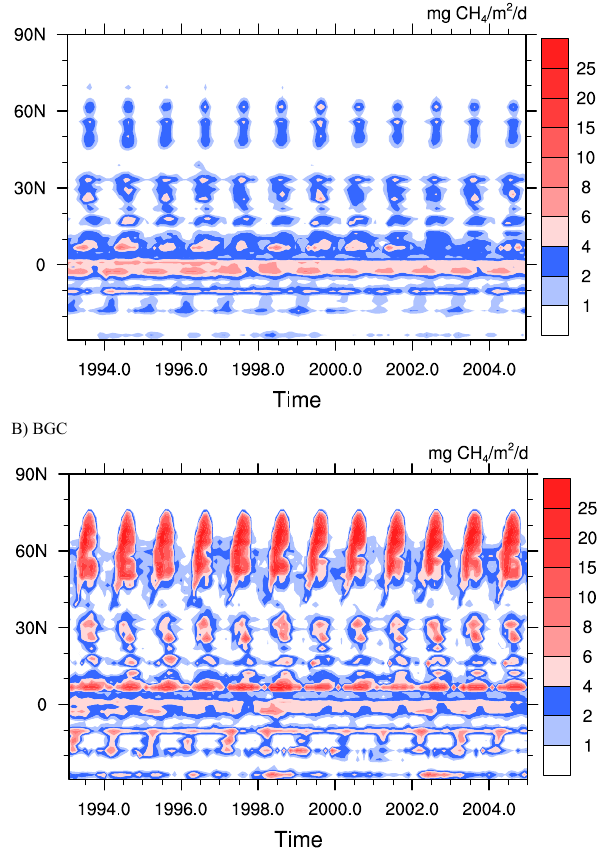
Figure 7. Zonal average monthly methane fluxes with time in CN_a (top, a ) and BGC (bottom, b )